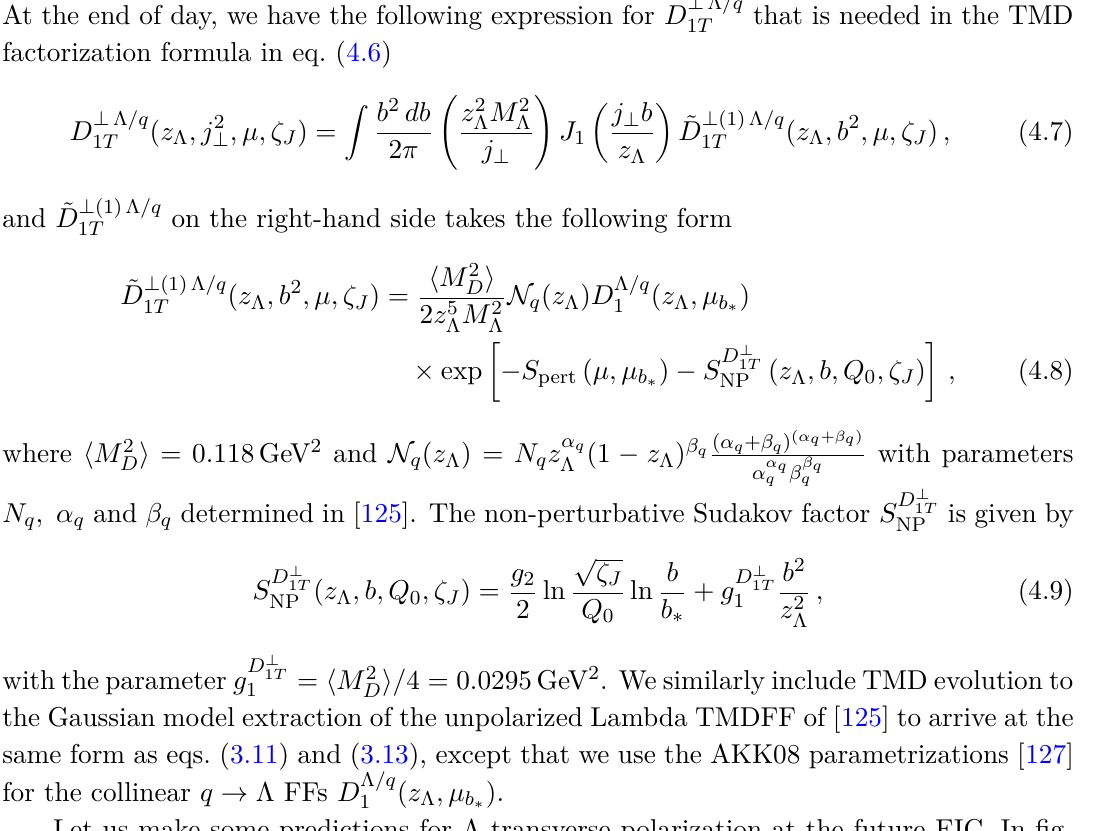
At the end of day, we have the following expression for D ⊥ Λ /q